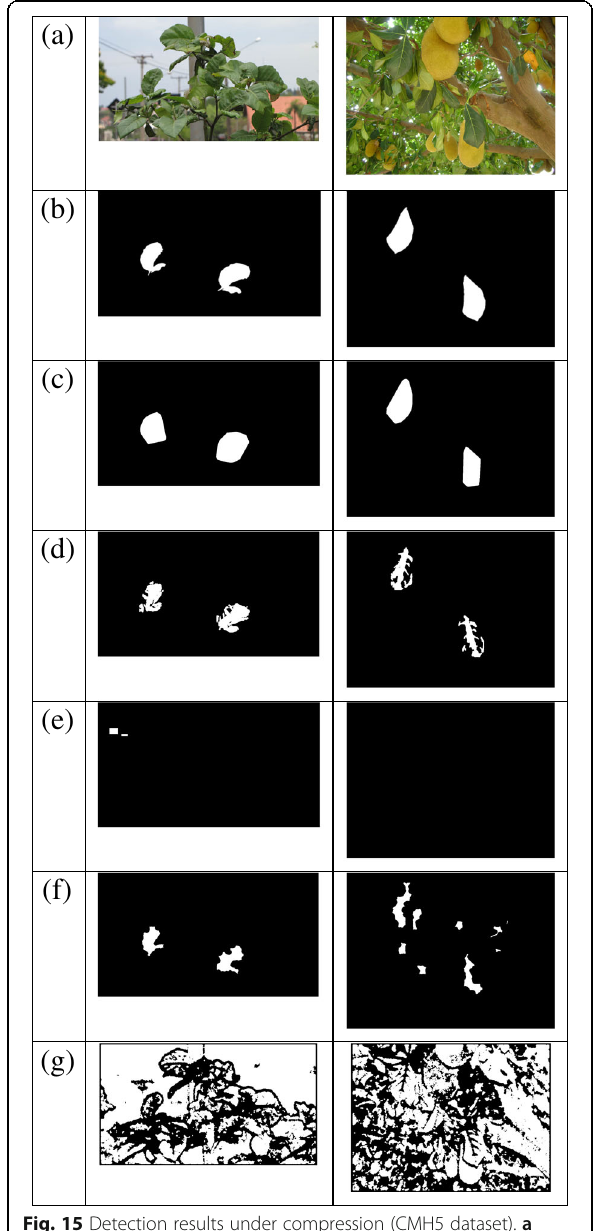
Fig. 15 Detection results under compression (CMH5 dataset). a Forgery images. b Ground truth. c Our proposed. d Amerini et al. [13]. e Silva et al. [16]. f Pun et al. [18]. g Li et al. [19]